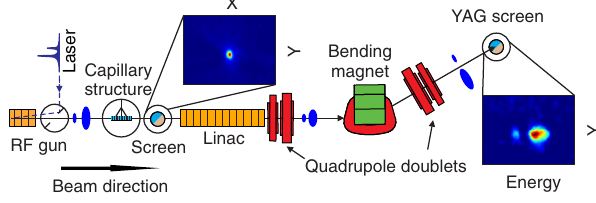
FIG. 2. Schematic view of driver-witness experiment.